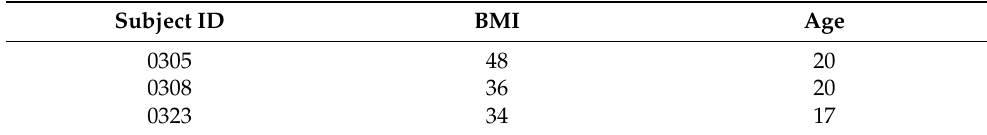
Table 1. Body Mass Index of unsuitable